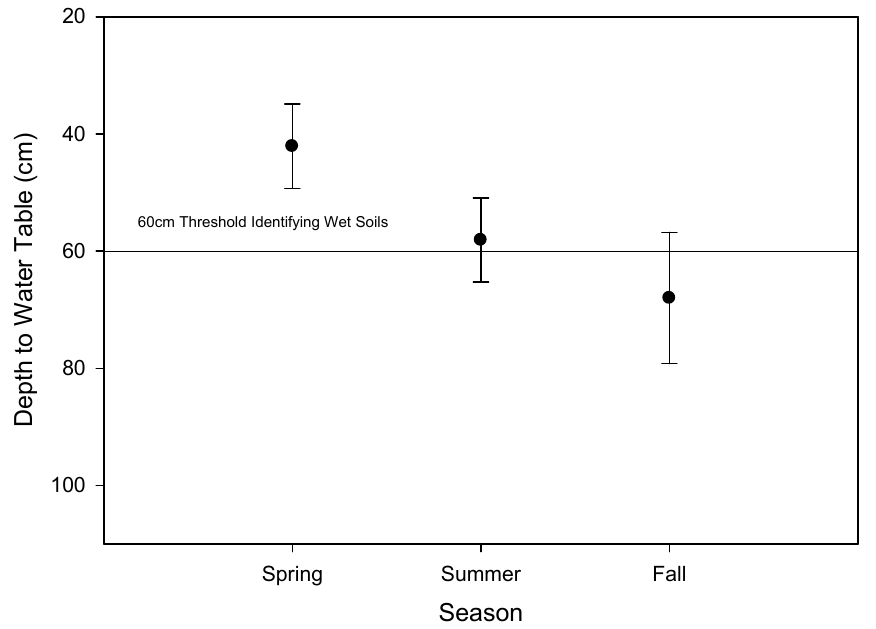
Figure 6. Seasonal average depth to water table at toe slope locations (error bars represent 95% CI, n = 27 spring and summer n = 13 for